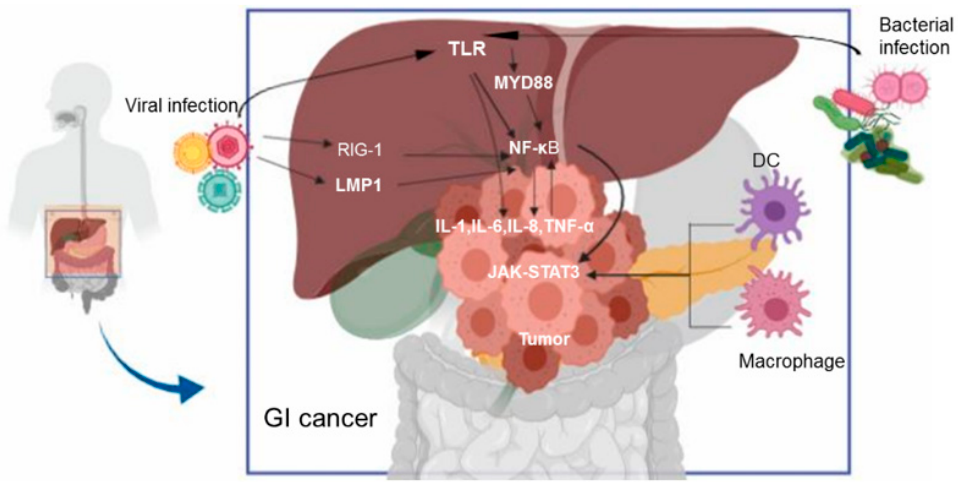
Figure 2. The mechanisms by which pathogens induce gastrointestinal cancer. Nuclear factor-kappa B (NF- κ B) is stimulated through virus-induced activation of toll like receptor (TLR), retinoic acid-inducible gene-1 (RIG-1) and Epstein–Barr virus latent membrane protein 1 (LMP1). Bacterial infection also can activate TLR and myeloid di ff erentiation primary response 88 (MYD88) to stimulate NF- κ B, which in turn promotes pro-inflammatory cytokines; IL-6, IL-1 β , IL-8, tumor necrosis factor- α (TNF- α ) and vice versa. The activation of pro-inflammatory cytokines promotes infiltration of dendritic cell, macrophages and other immune cells which activates Janus kinase / signal transducer and activator of transcription 3 (JAK-STAT3). The inflammatory responses and NF- κ B activation promotes cell proliferation and cancer initiation. In addition, the cross-talk between (NF- κ B) and JAK-STAT3 stimulate cell growth, angiogenesis and thus accelerate